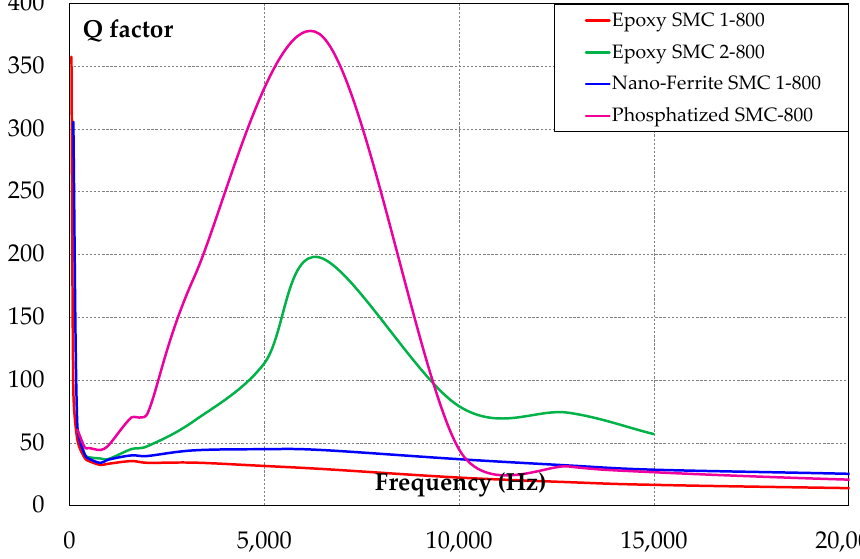
Figure 12. RCL measurement setup: detection of the DC resistance value . Figure 14 shows the resistance values of rod inductors: after soft ferrites, the minor losses are represented by the commercial product; instead, epoxy SMC 1-800 showed the most significant losses concerning all other considered samples. The corrected quality factor trends over frequency showed a different peak value and frequency for each material, as shown in Figure 15. The differences were related to the balance between the (static) hysteresis losses and the rise in the dynamic (frequency dependent) losses.